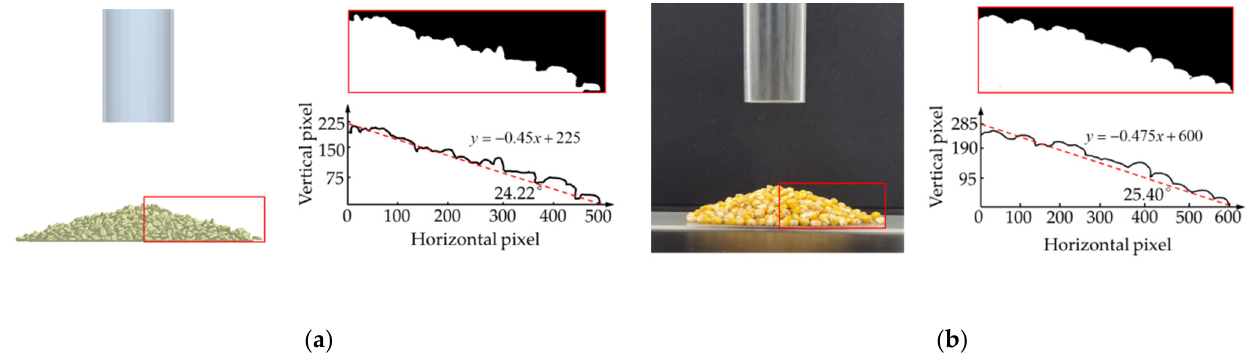
Figure 4. Comparative determination of natural rest angle of corn grain by simulation and experiment: ( a ) EDEM simulation results; ( b ) bench test results.